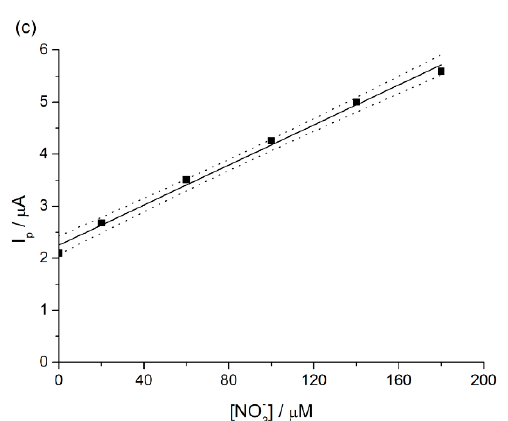
Figure 3. ( a ) Linear sweep voltammograms recorded in acidified river water at 10 mV s − 1 (blank: Dotted line); ( b ) first derivative of LSVs reported in ( a ); ( c ) calibration plot, with confidence bands at 90%, obtained by standard additions for the following concentrations in µ M: 1) 0, 2) 20, 3) 60, 4) 100, 5) 140, 6) 180.